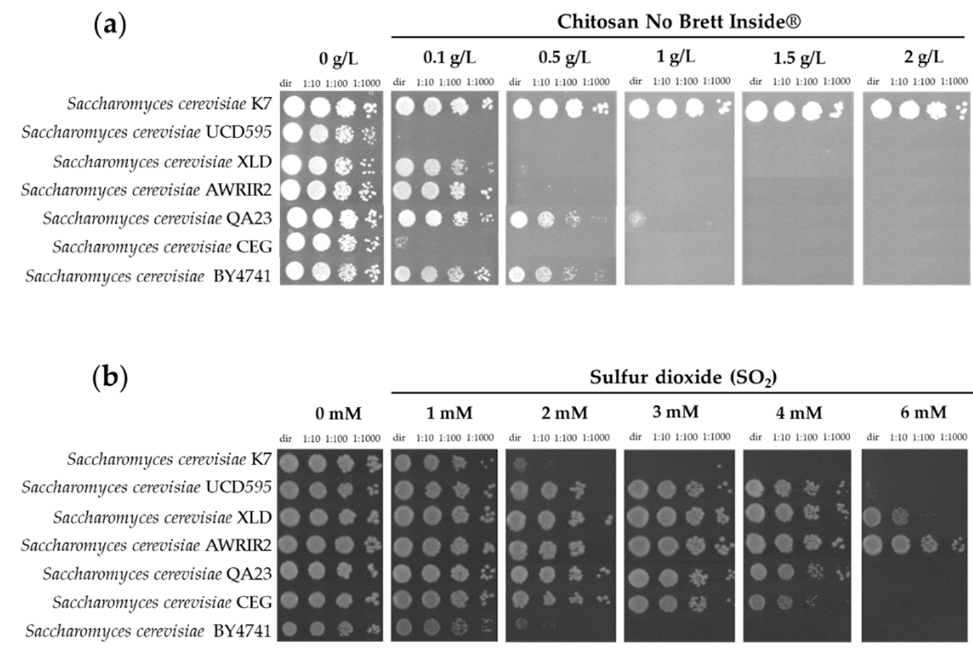
Figure 2. Spot assay of non- Saccharomyces yeast strains at several concentrations of ( a ) chitosan and ( b ) SO 2 . Ten-fold dilutions were spotted on an MMB plate or YPD (respectively) and incubated for 2 to 3 days.